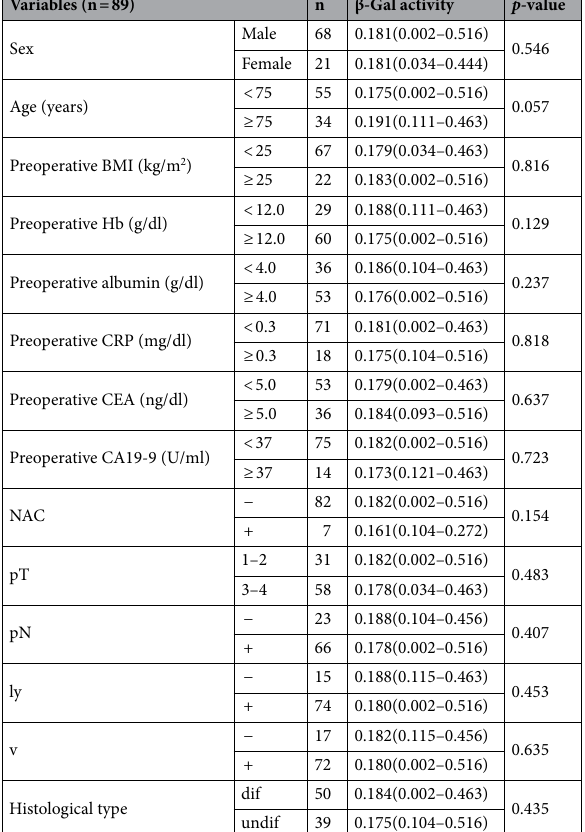
Table 1. β-Gal activity of each clinicopathological factor. Values of p were obtained by Wilcoxon test. BMI body mass index, CRP C-reactive protein, CEA Carcinoembryonic antigen, CA19-9 carbohydrate antigen 19-9, NAC neoadjuvant chemotherapy, dif differentiated, undif